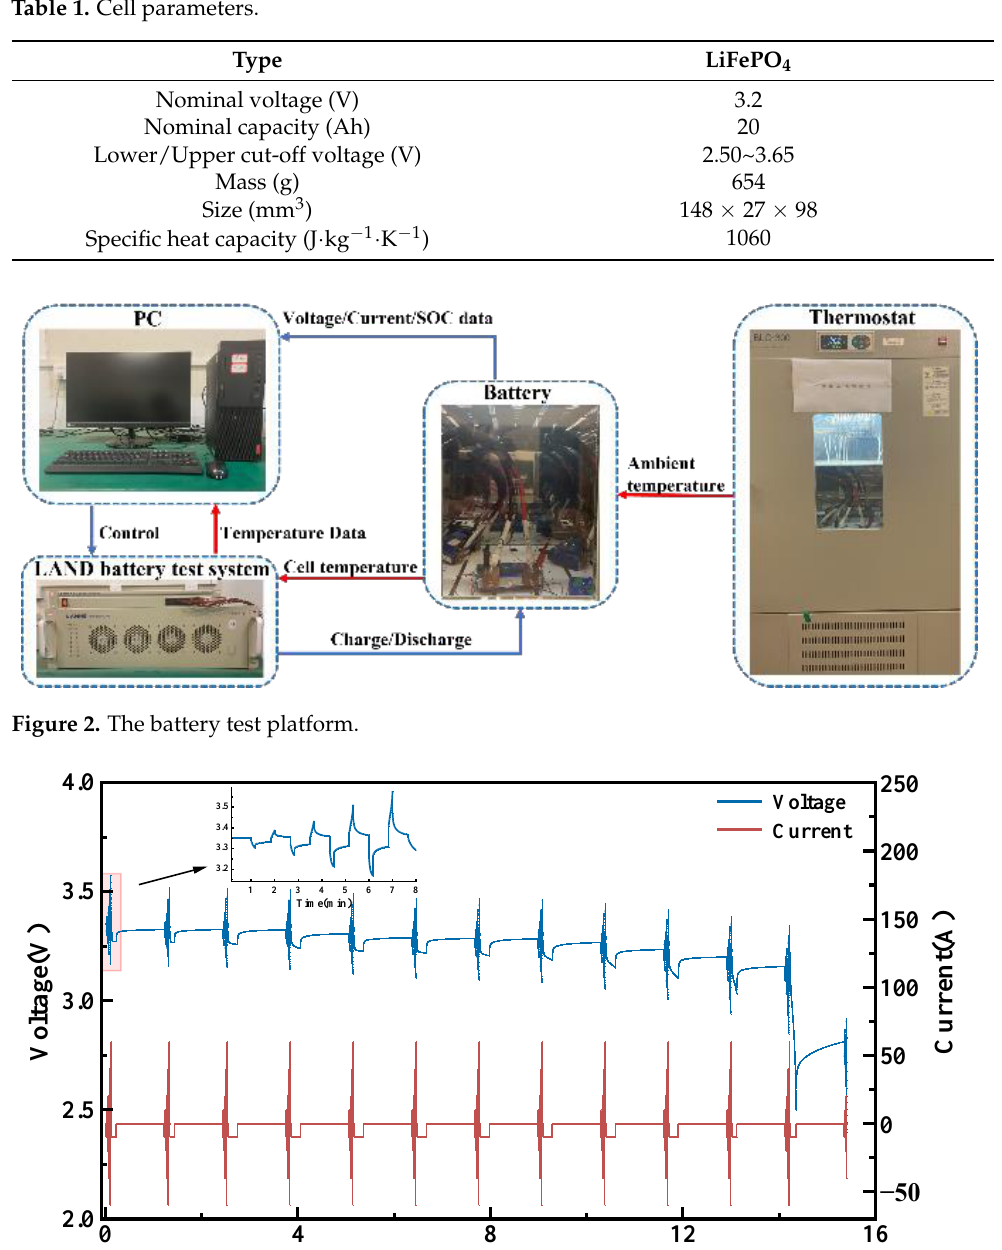
Figure 3. Voltage and current of HPPC experiments.